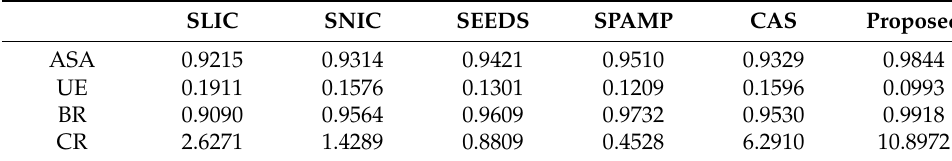
Table 2. Segmentation metrics of SI 3 by four